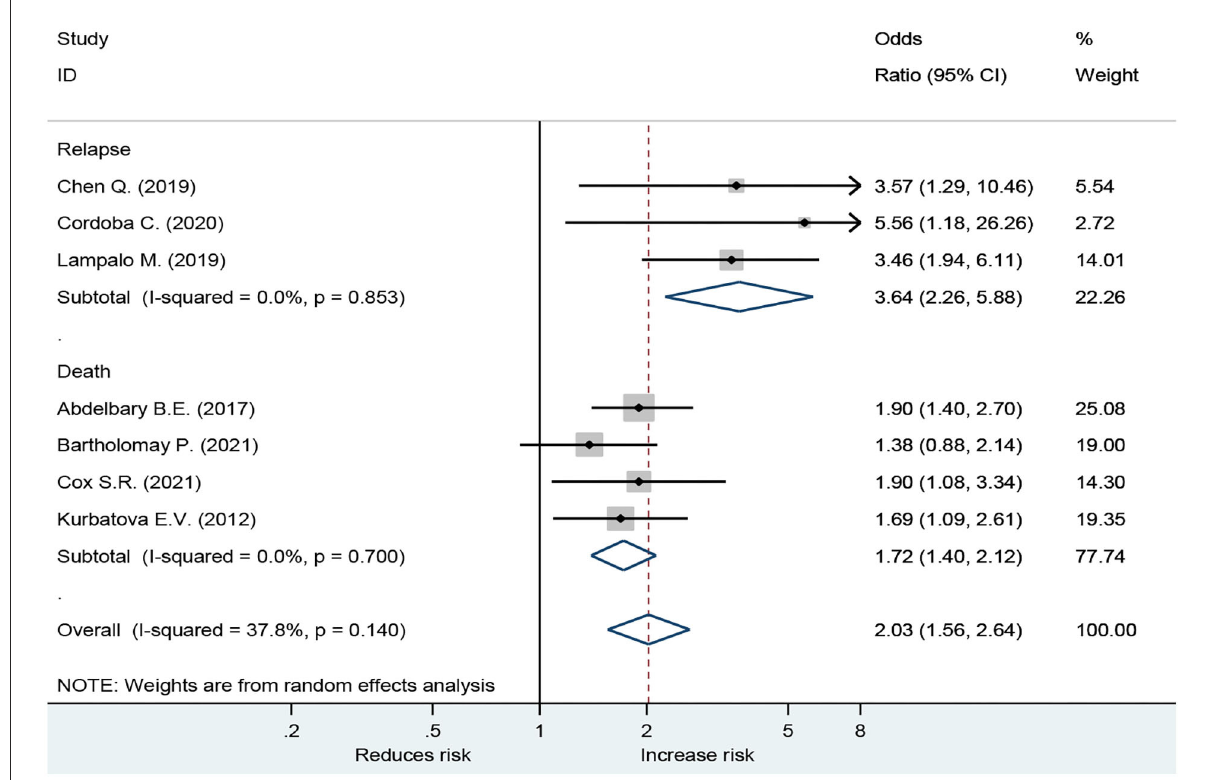
FIGURE2 Forest plot showing odds ratio of tuberculosis relapse and death among